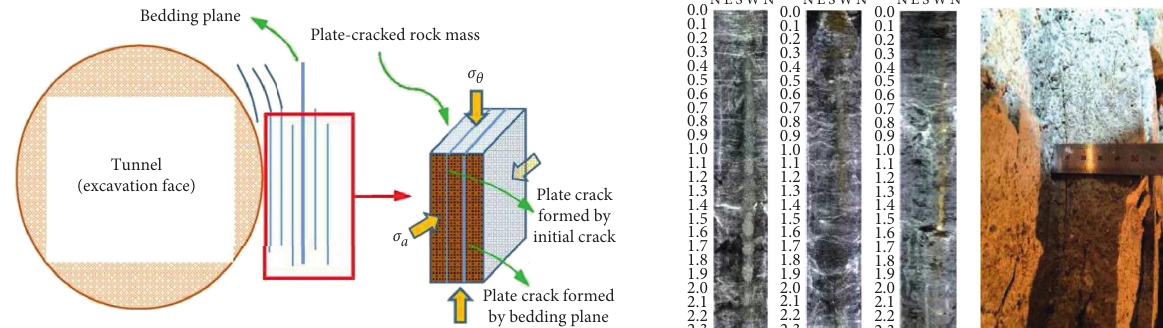
Figure 1: The damage phenomena of plate crack in rock